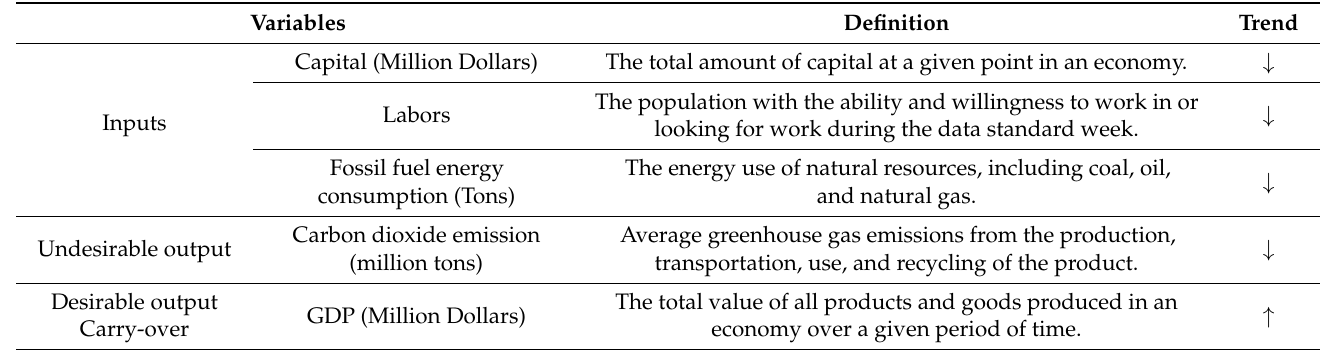
Table 4. The definitions of inputs, outputs, and carry-over